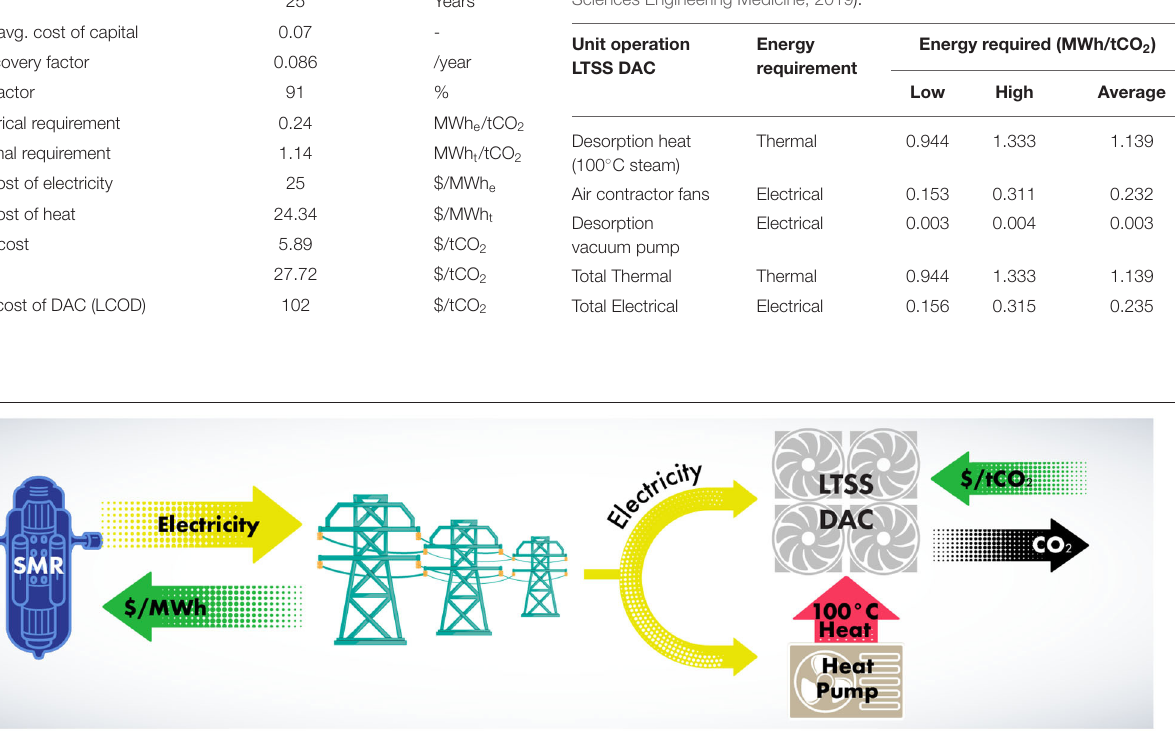
FIGURE 1 | Baseline